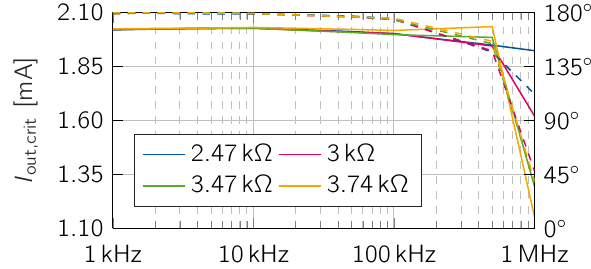
Figure 10: Output current of the EHCS measured for load values in the range of the theoretical maximum operable load 3.5 k (cid:10) . Loads above of 2.47 k (cid:10) experience a significant drop in magnitude (rms value, solid line) and phase (dashed line).